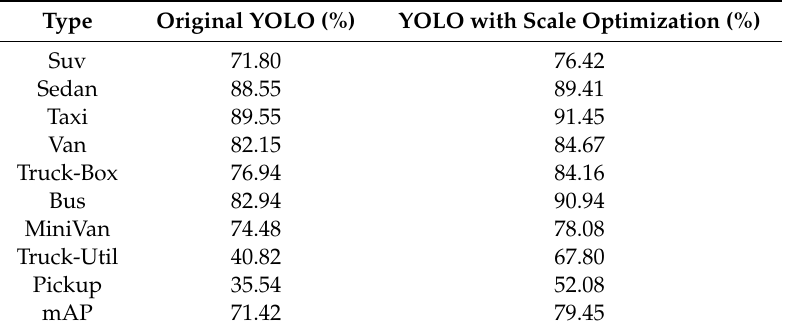
Table 1. Comparison of accuracy between the original YOLO algorithm and its improved algorithm.